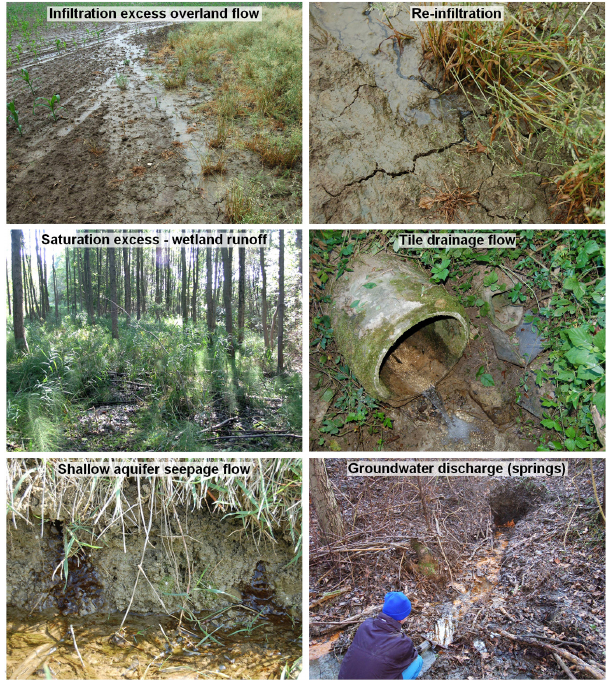
Figure 5. Runoff generation mechanisms in the